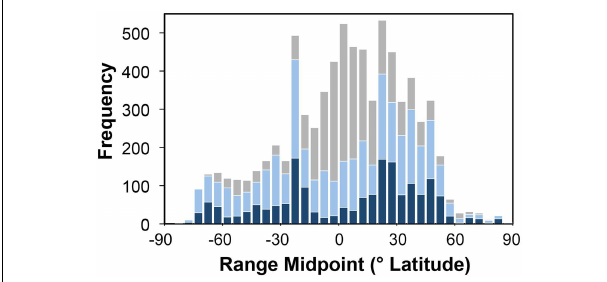
FIGURE 3 | Latitudinal trends in species range sizes. Frequency of species latitudinal range midpoints occurring in each 5 ◦ latitudinal band. The number of small ranged species (latitudinal ranges < 20 ◦ ) is shown as blue bars (light blue for species with < 6 records, dark blue for species with ≥ 6 records); gray bars show larger ranged